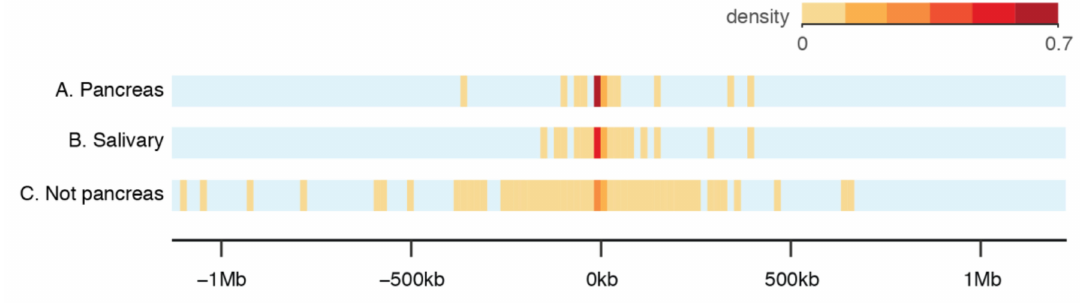
Figure 9. Integrating ATAC-seq with RNA-seq data can help validate novel genes. ( A ) Of the 44 novel genes expressed in the pancreas, most are less than 25 kb from a pancreas ATAC-seq peak. For those closest to ATAC-seq peaks, integrating RNA-seq and ATAC-seq provides additional evidence that they are real genes. ( B ) 58 novel genes expressed in the salivary gland (including 15 also expressed in pancreas) do not cluster as closely to pancreas ATAC-seq peaks, suggesting tissue specificity. ( C ) 491 novel genes not expressed in the pancreas are much more dispersed relative to the ATAC-seq peaks in the